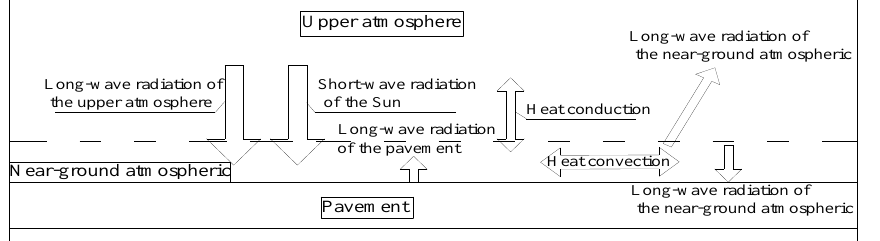
Figure 6. Heat balance of atmospheric surface layer.